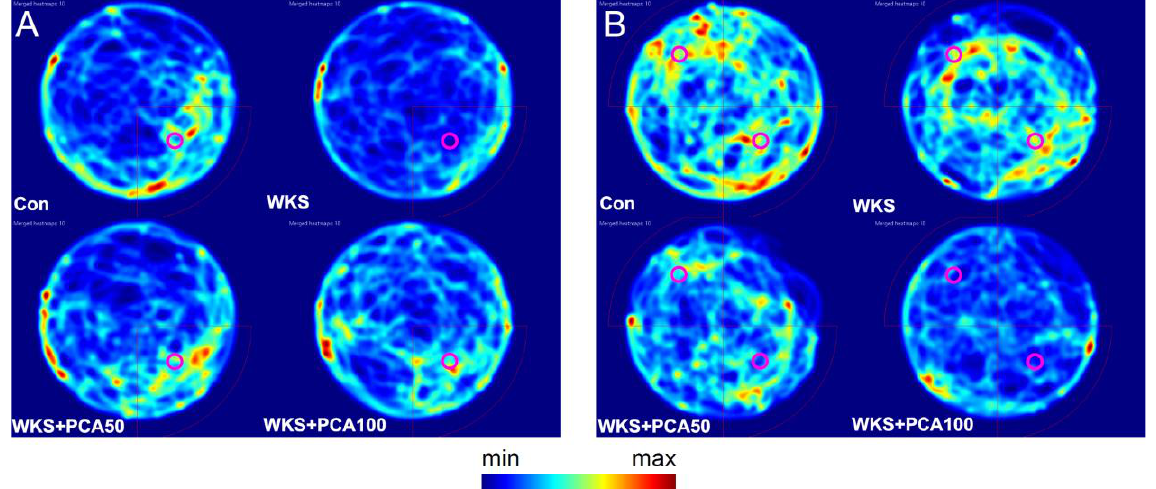
Figure 10. Heat maps showing the spatial distribution of time spent by each group of animals at each pool location: ( A ) in the first memory test and ( B ) in the second memory test in MWM. The circle slices represent the SE and NW target quadrants along with platform location during the training phases (red circles in the lower right or upper left corner of each map).